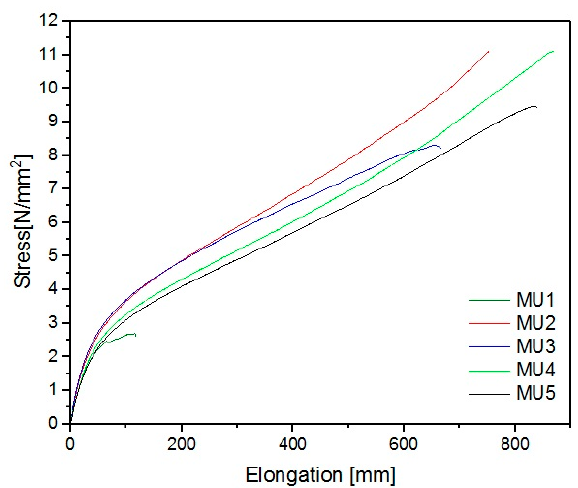
Figure 21. Elongation-stress curves for all composites obtained during stretching test.